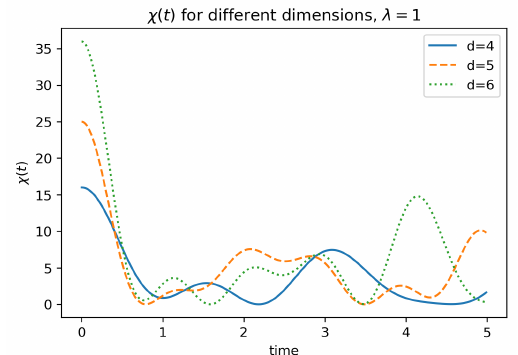
Figure 2: The function χ ( t ) , defined in (15), for the spectrum of a Hamiltonian drawn from the d = 4,5,6 GUE, respec- tively.